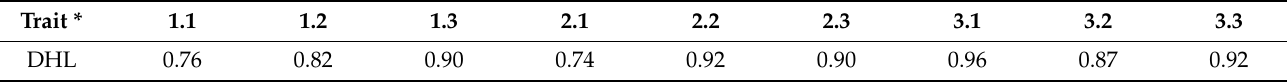
Table 4. Correlations among the nine traits and direct herd life for Korean Holstein. Trait